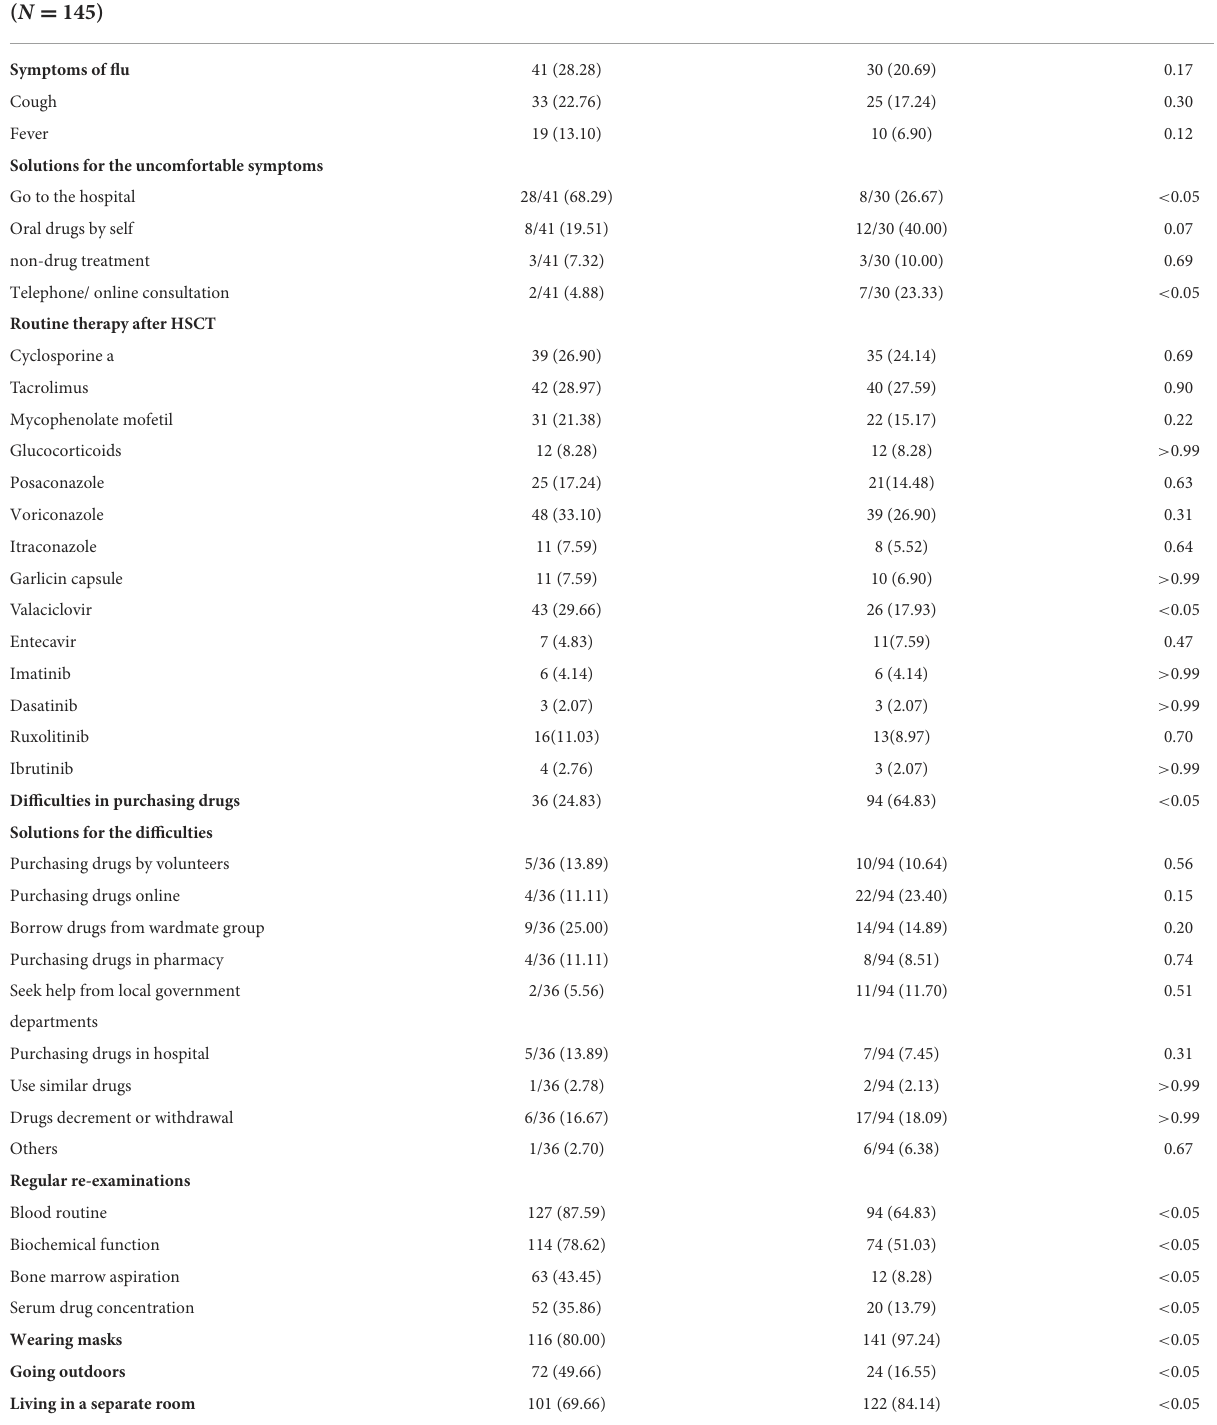
TABLE 3 The influences of the COVID-19 epidemic on medical treatments and daily behavior patterns.